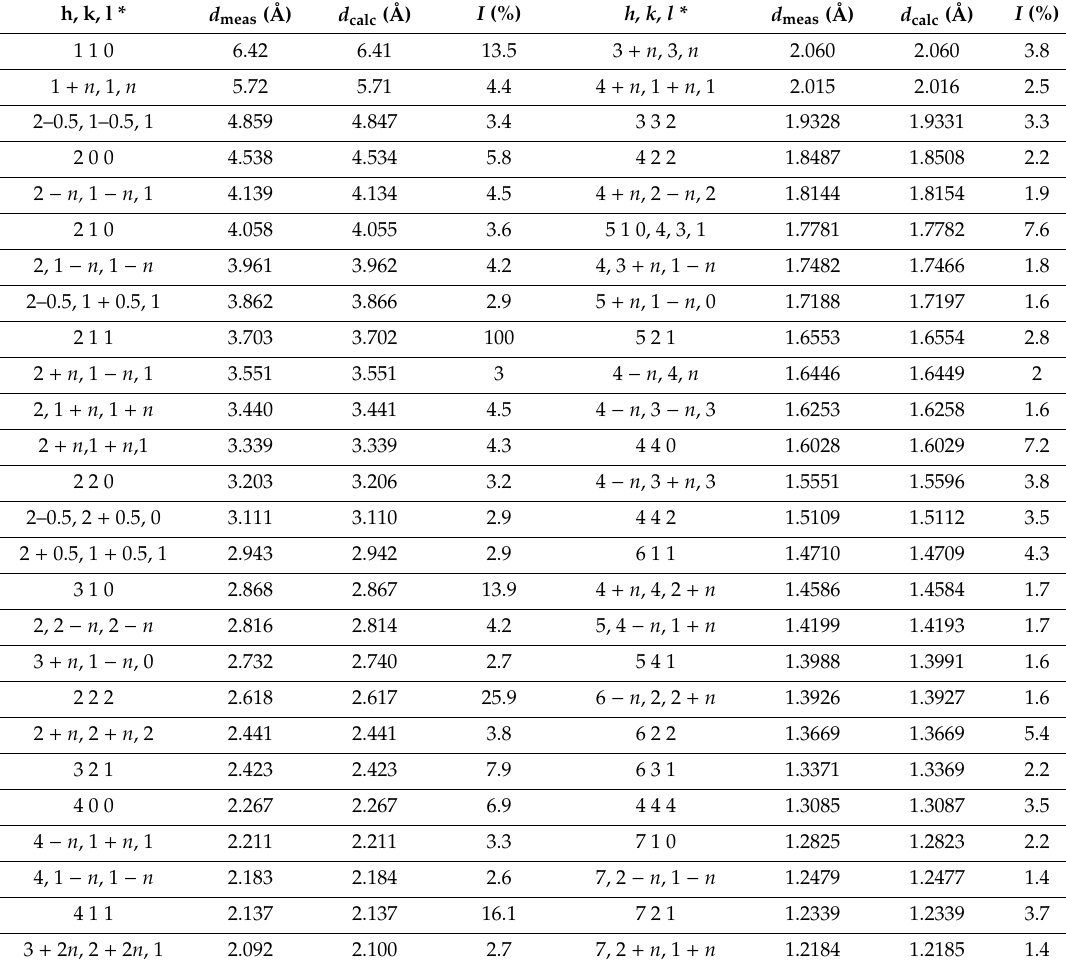
Table 3. Powder X-ray di ff raction data of the MD